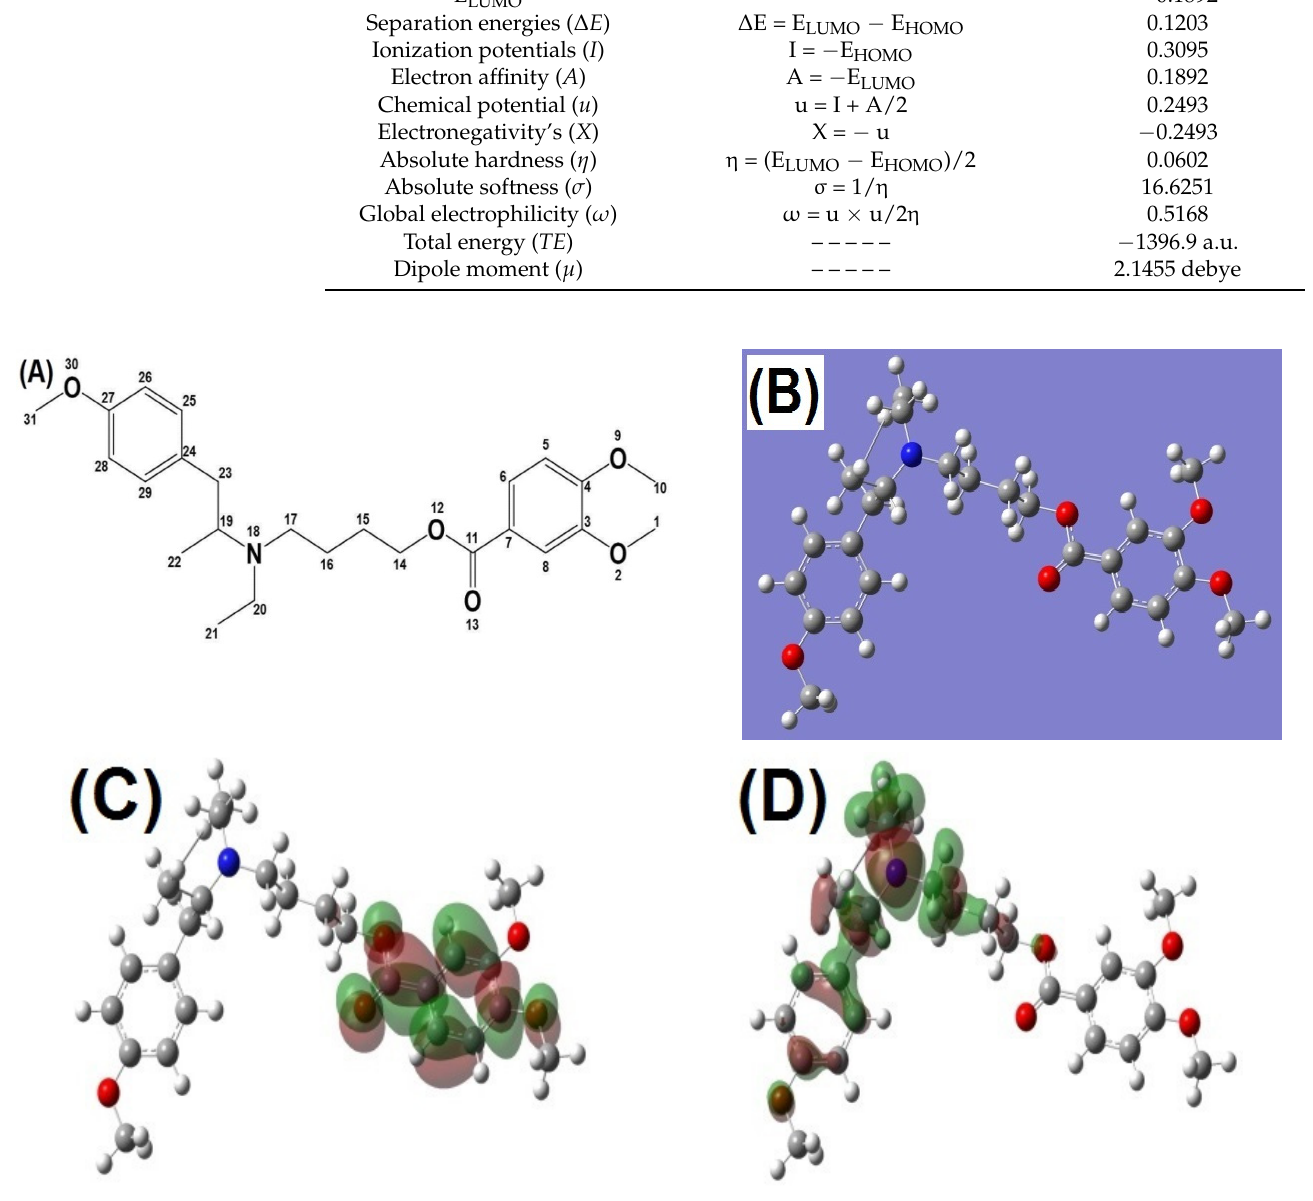
Figure 7. ( A ) Numbered structure and optimized structure of ( B ) molecular orbital, ( C ) HOMO and ( D ) LUMO of MEB.